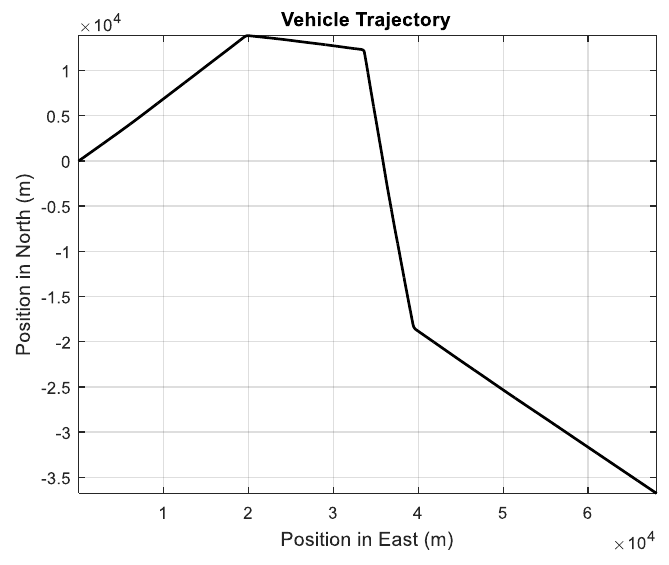
Figure 2. The vehicle trajectory.